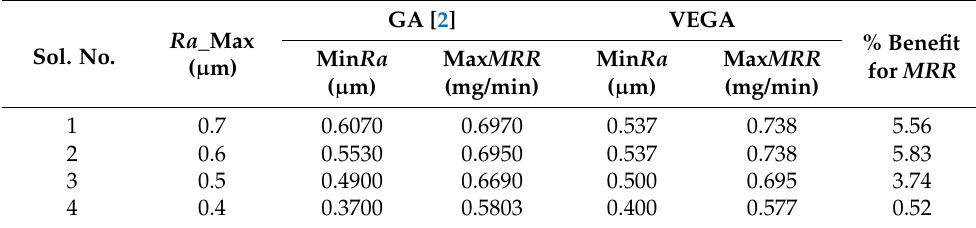
Table 3. Optimal pairs of conventional abrasive flow nano-finishing process parameters obtained using